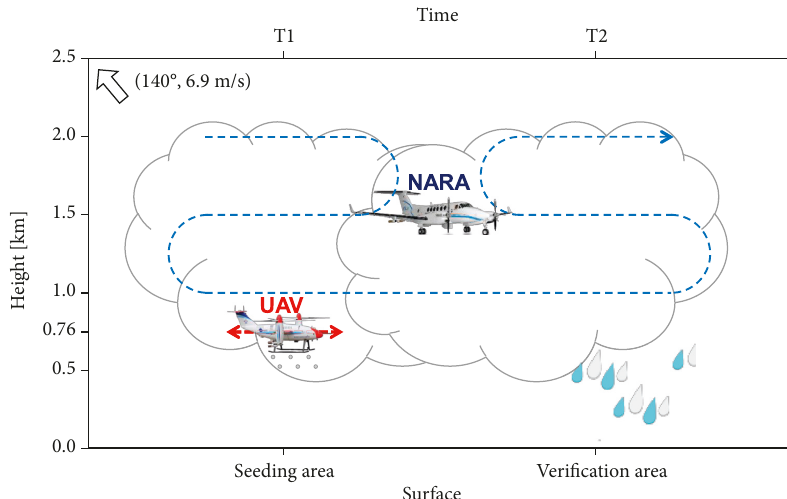
Figure 10: Schematic diagram of cloud seeding experiment by UAV (red) and NARA